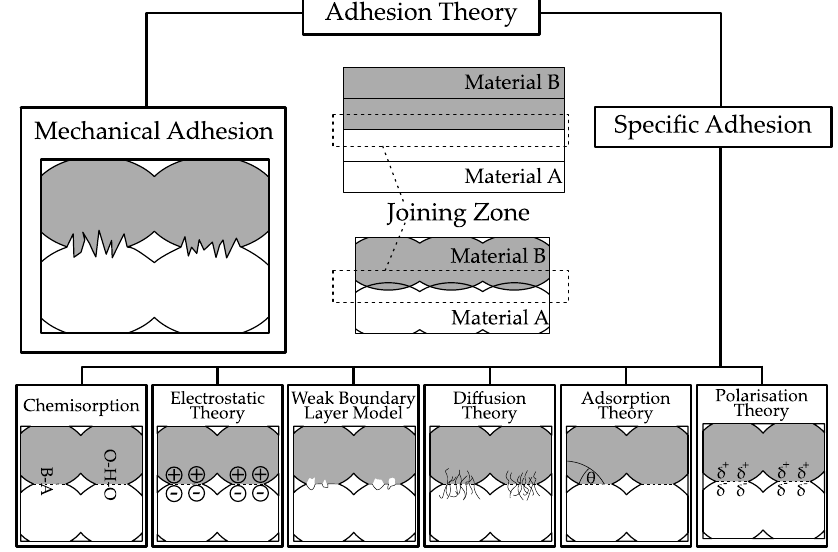
Figure 3. Schematic diagram of adhesion mechanisms. Based on [8,18].